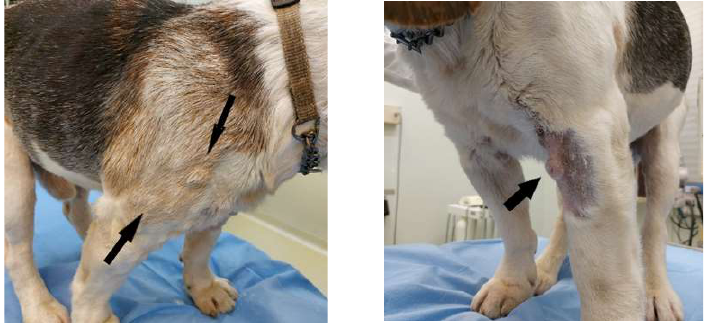
Figure 1. Clinical presentation of a dog with cutaneous non epitheliotropic B-cell lymphoma (CNEBL) with plasmablastic differentiation vs. multiple cutaneous plasmacytosis (CP). Note the presence of skin nodules of various sizes disseminating throughout the body (arrows).